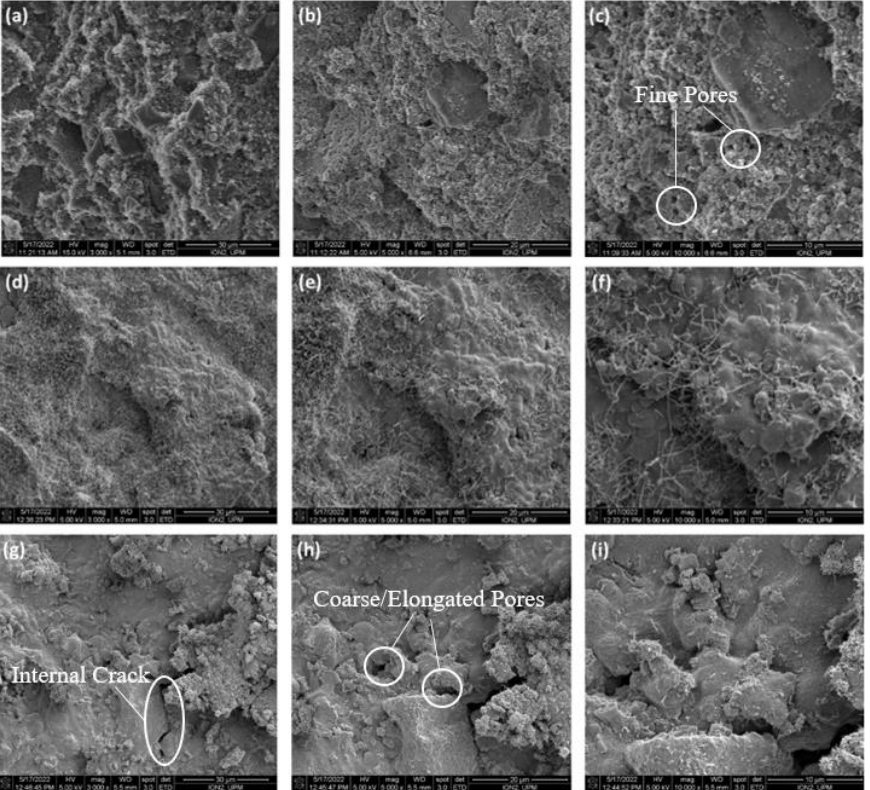
Figure 3. FESEM images of aluminum samples’ cross-sections with magnifications of 3000 × , 5000 × , and 10,000 × from left to right. ( a , d , g ) RHA-10 wt.%, ( b , e , h ) RHA-15 wt.%, ( c , f , i ) RHA-20 wt.%. Table 1. Elements that were detected for each case through EDX analysis. Qualitative Results, wt.% Specimens